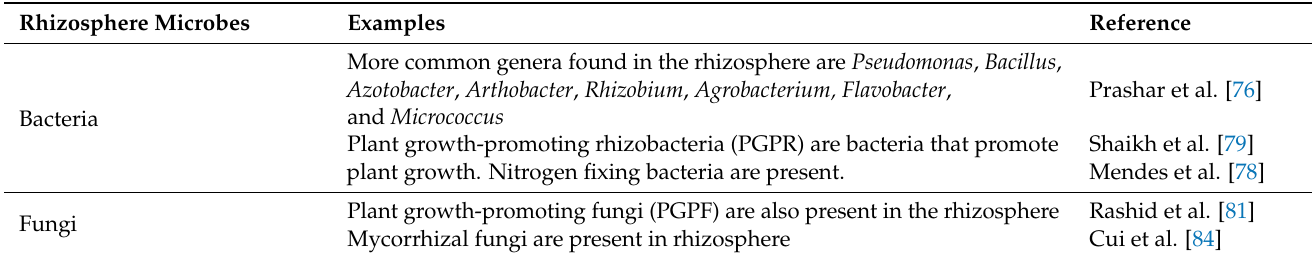
Table 2. Main rhizosphere